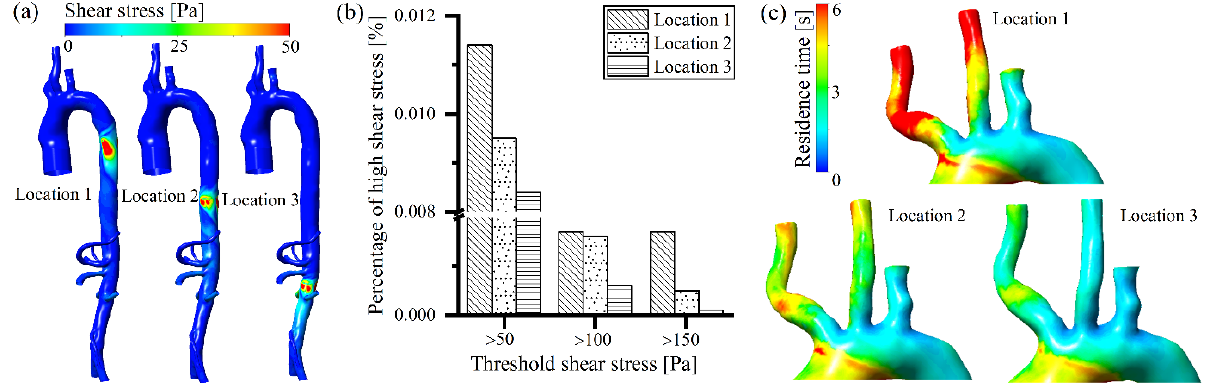
Figure 4. Effects of different pump positions on blood damage-related parameters (shear stress and residence time): ( a ) arterial shear stress distribution; ( b ) high shear stress volume comparison; ( c ) residence time distribution on aorta arch.